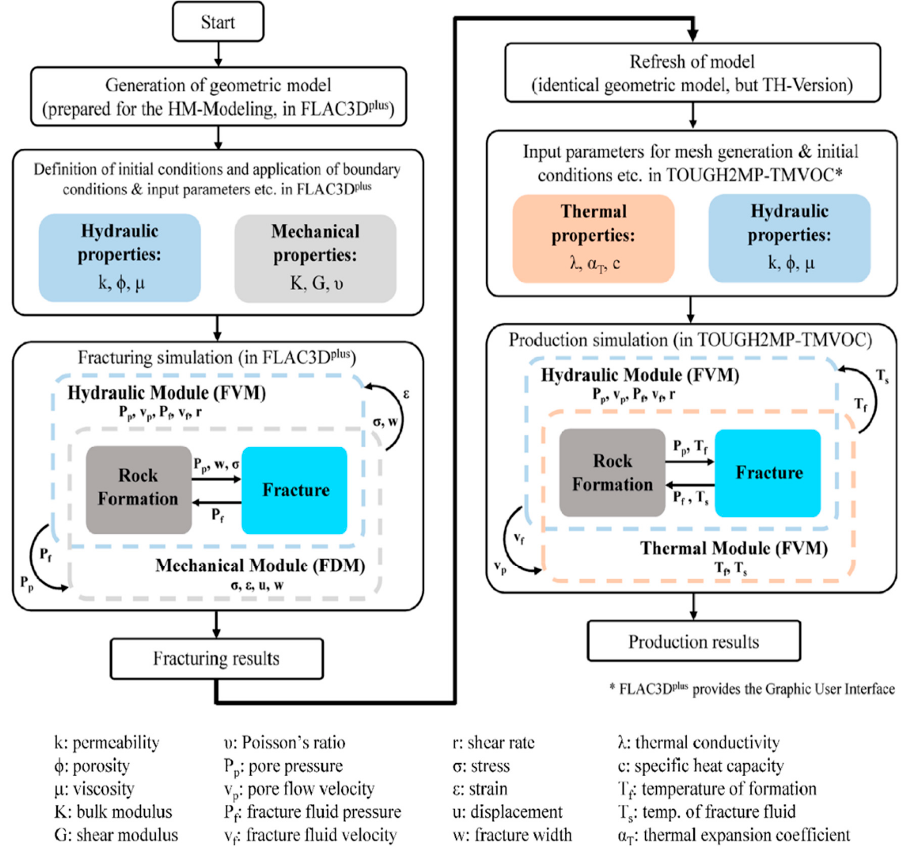
Figure 1. Flow chart of the computing scheme during the numerical modelling.